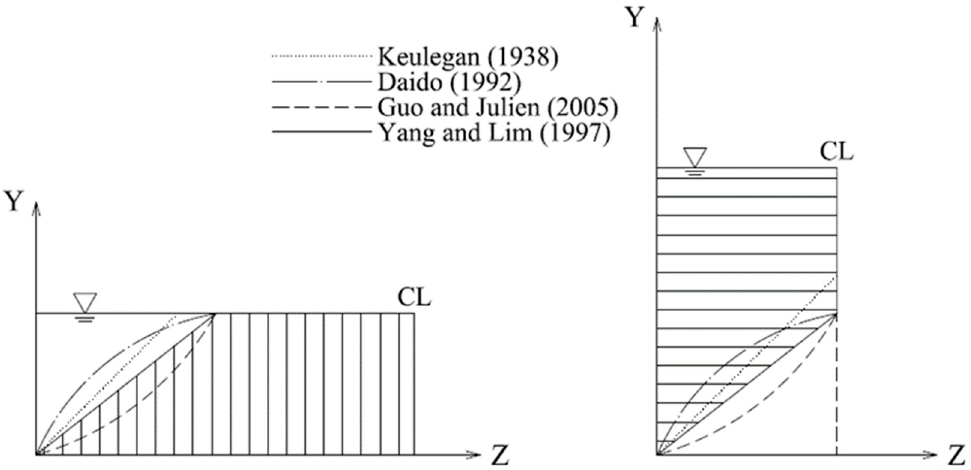
Figure 1. Different views on the division of the flow region. Figure 1. Di ff erent views on the division of the flow